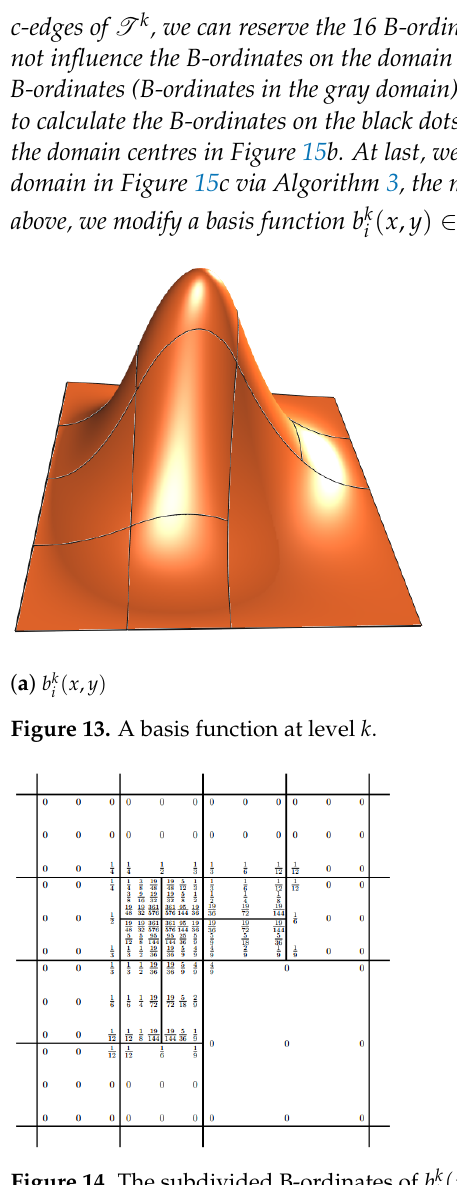
Figure 14. The subdivided B-ordinates of b k